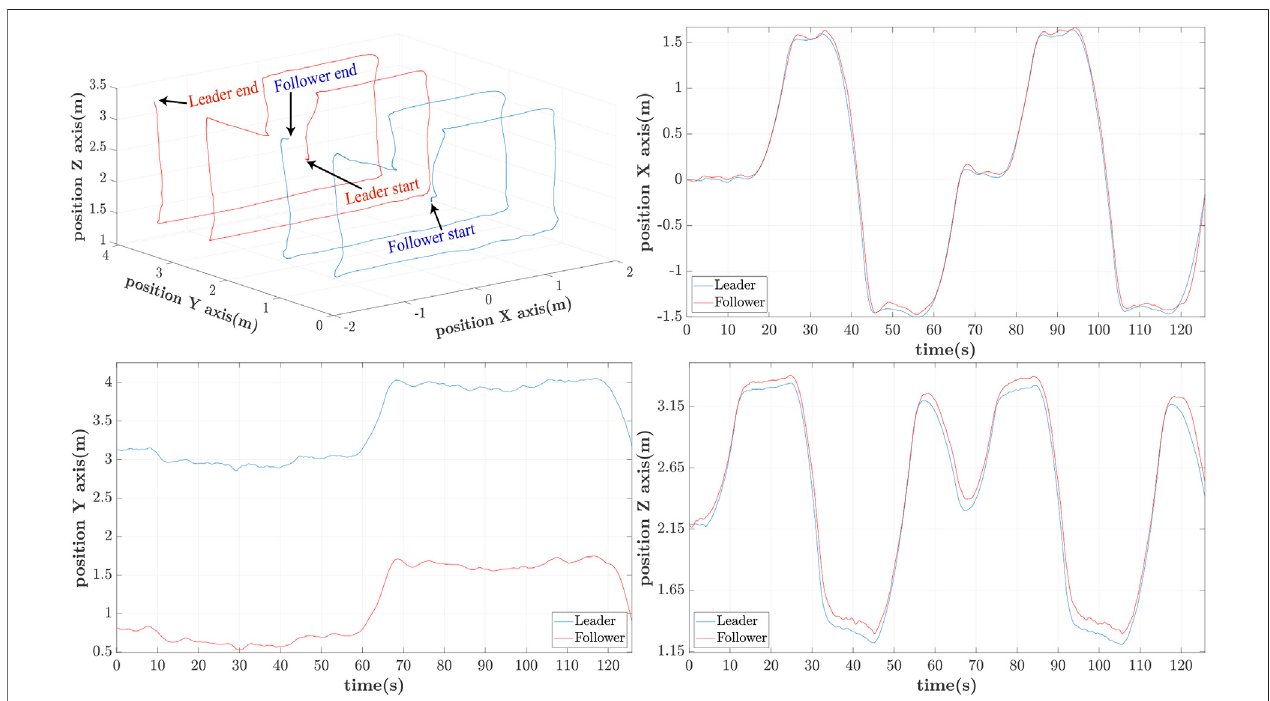
FIGURE 10 | 3D Leader/Follower trajectories with h (cid:2) 0.25s delay.